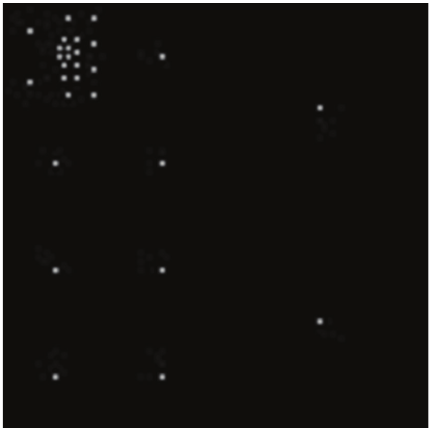
Figure 6: The forecasted TITI at 10.30 a.m.